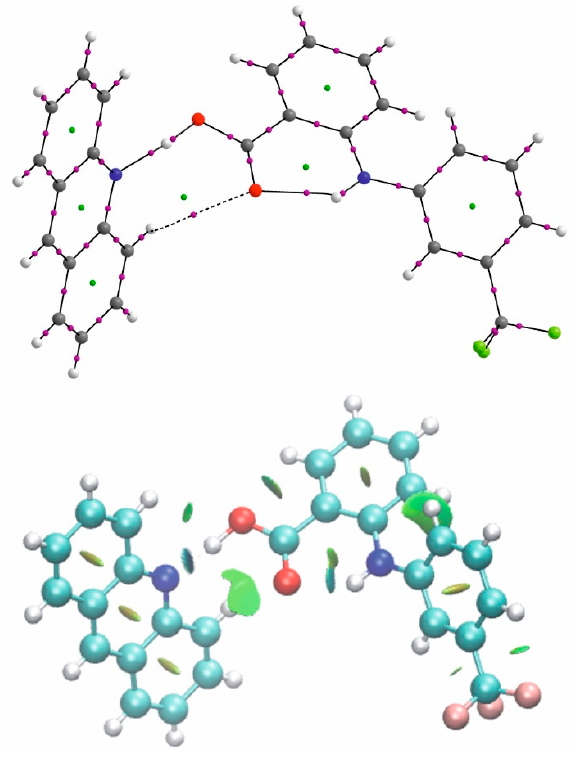
Figure 6. The QTAIM and NCI diagram for flufenamic acid–acridine complex.